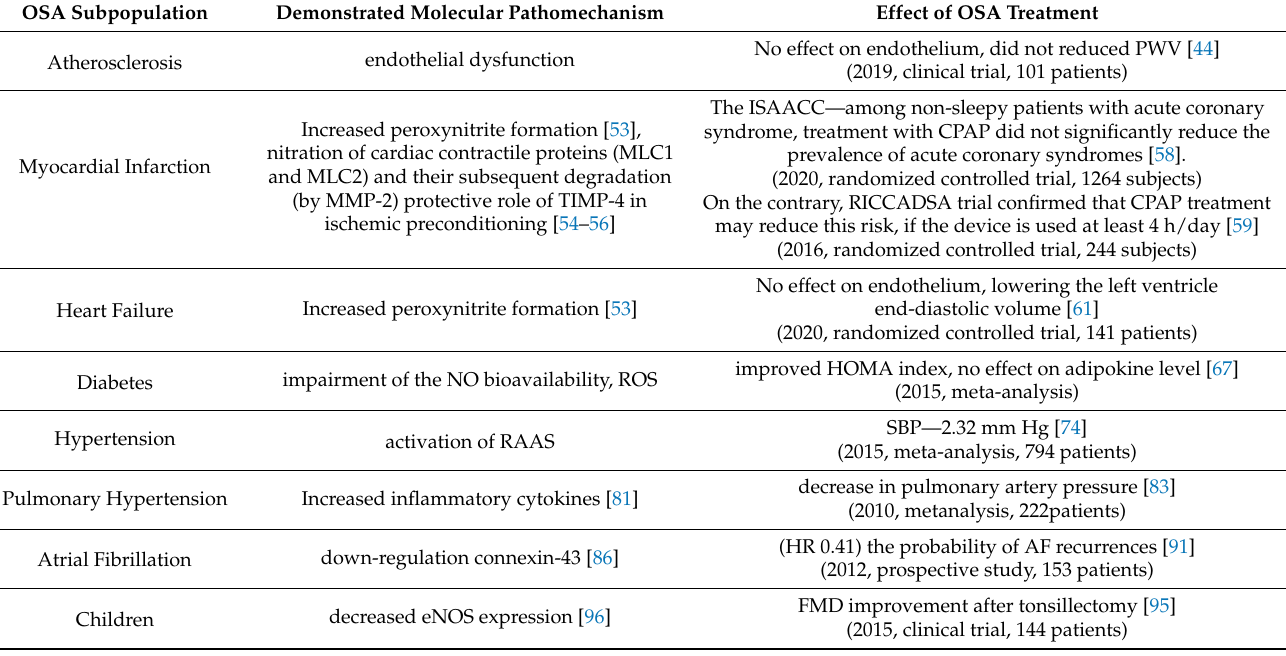
Table 1. Endothelial function after treatment in specific